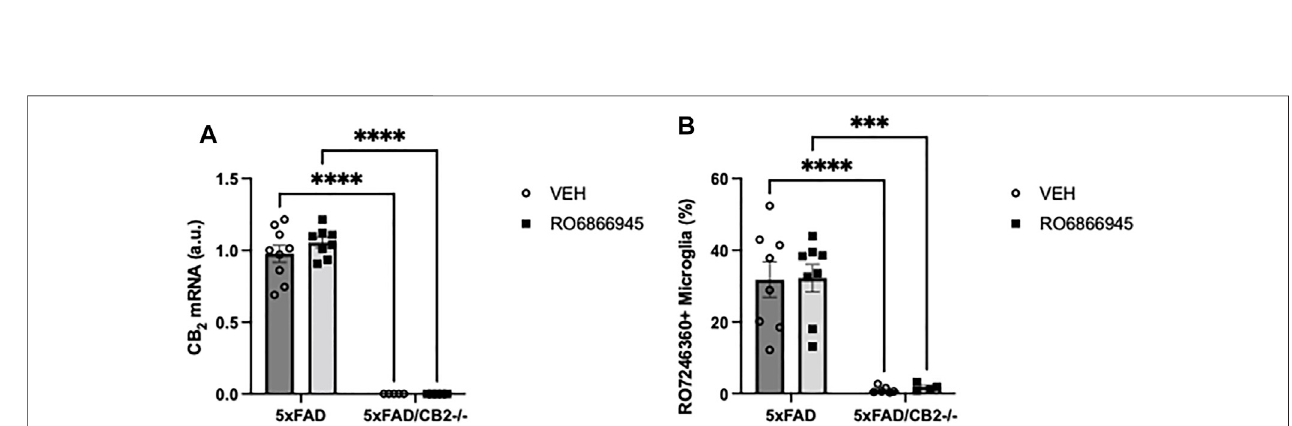
FIGURE 3 | The chronic exposure to the CB 2 selective agonist, RO6866945, did not modify the expression of cannabinoid CB 2 receptors. (A) mRNA levels of the cannabinoid CB 2 receptor did not vary after treatment with RO6866945 but were completely absent in 5xFAD/CB 2-/- mice. (B) Binding of the fl uorescent probe RO7246360 to cannabinoid CB 2 receptors was used to quantify protein levels, revealing no changes after treatment with the agonist and the negligible levels of CB 2 proteinin5xFAD/CB 2-/- mice.Two-wayANOVAfollowedbyTukey ’ spost-hoctest.** < p 0.01;**** < p 0.0001.N=4 – 9micepergroup.Datarepresent mean±SEM.